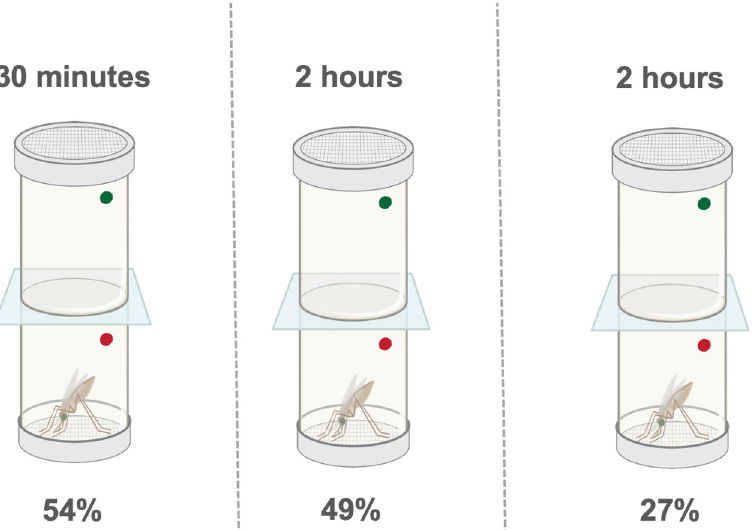
Fig 7. Selection regime for the susceptible colony. WHO deltamethrin tube selection regime implemented to reselect Banfora S to full resistance. The generations are shown separated by a dashed line. The durations of each exposure to 0.05% deltamethrin are given above the tube, with the mean mortality for each generation below. Mortality for the first two selections are calculated based on entire colony selection (N = 409; N = 514), whilst the final calculation of mortality represents a subset of the selected cage (N =